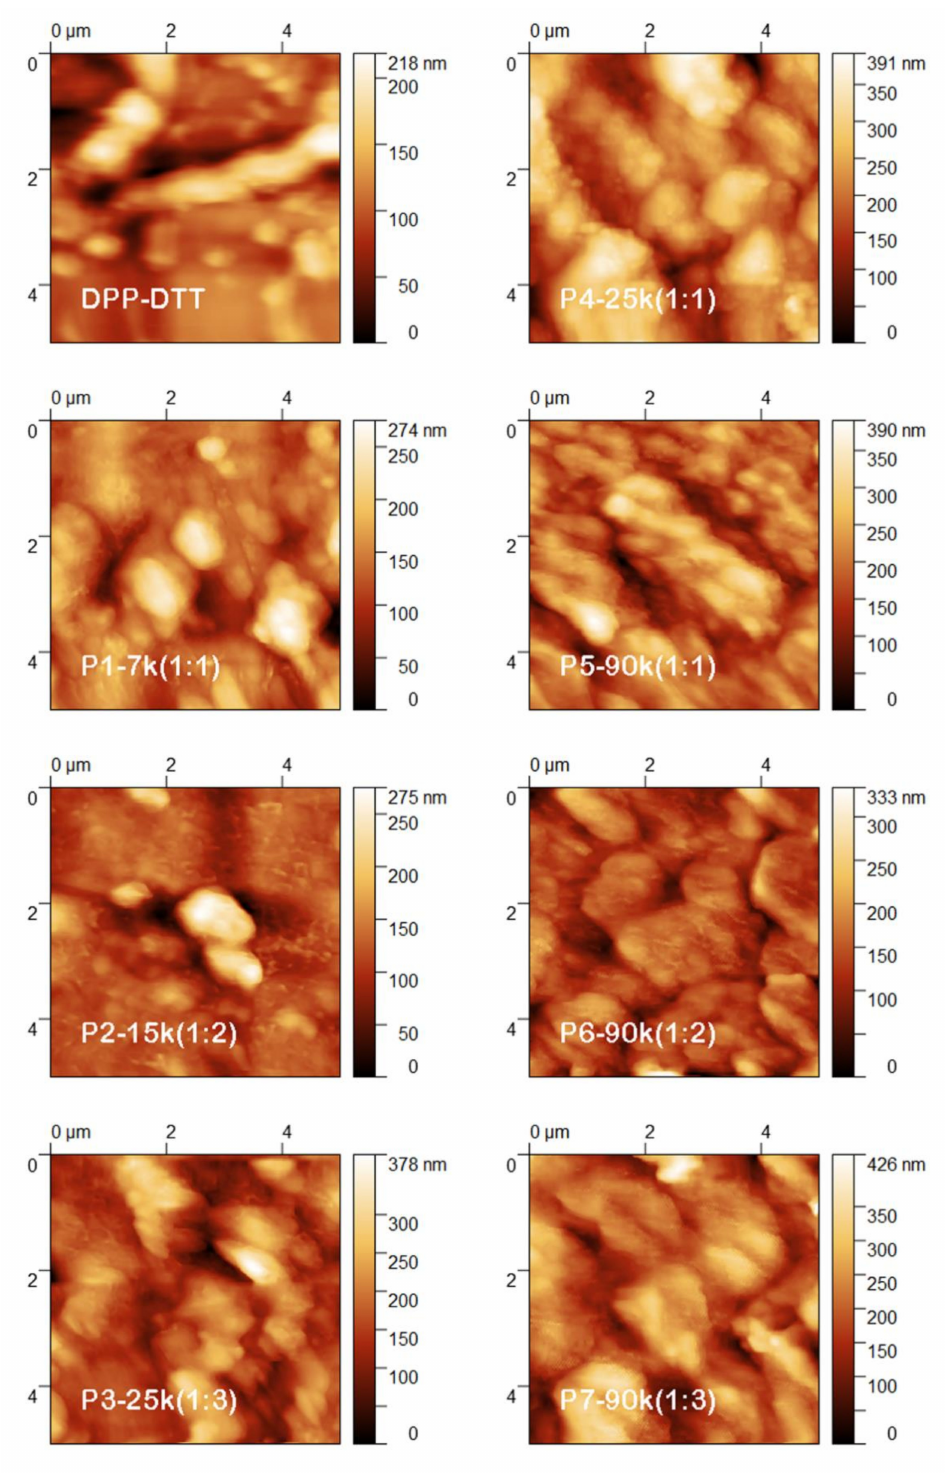
Figure 6. Topographic images of the layers deposited by MAPLE on ITO /